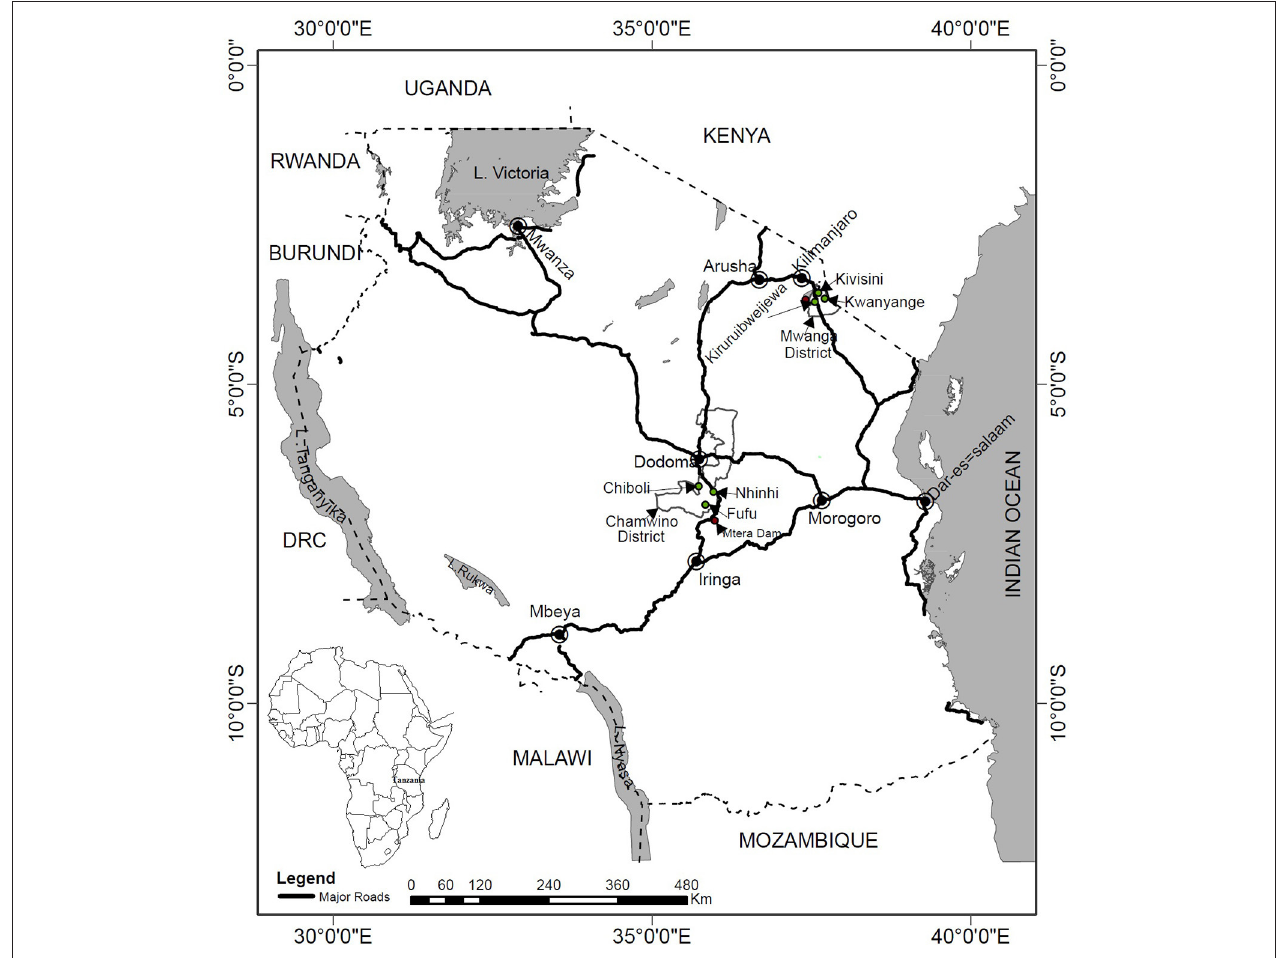
FIGURE 1 | Study villages in Chamwino and Mwanga districts.